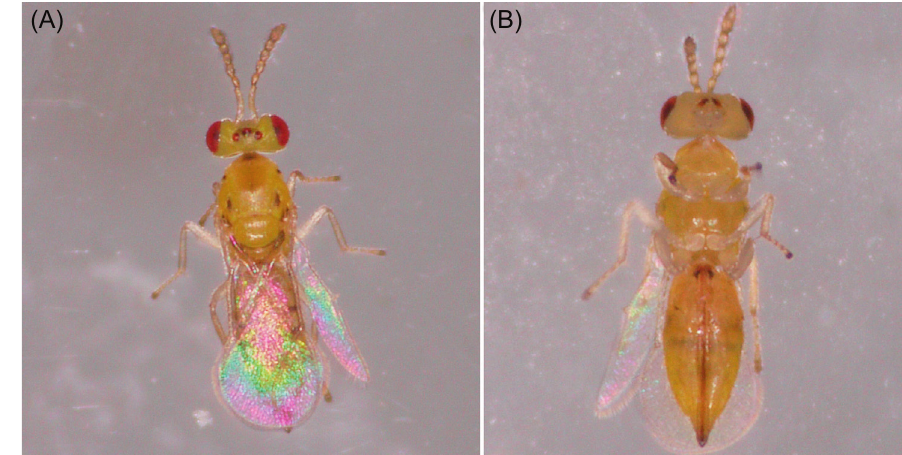
Figure 3. (A) Dorsal view of Quadrastichus mendeli female; (B) ventral view of Q. mendeli female.